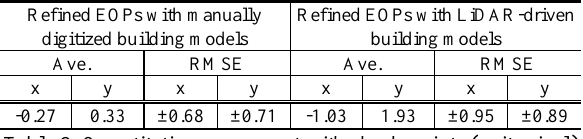
Table 2. Quantitative assessment with check points (unit: pixel)